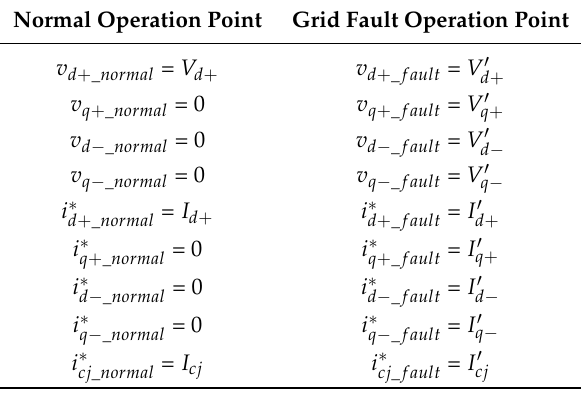
Table 1. Quiescent operation point of the